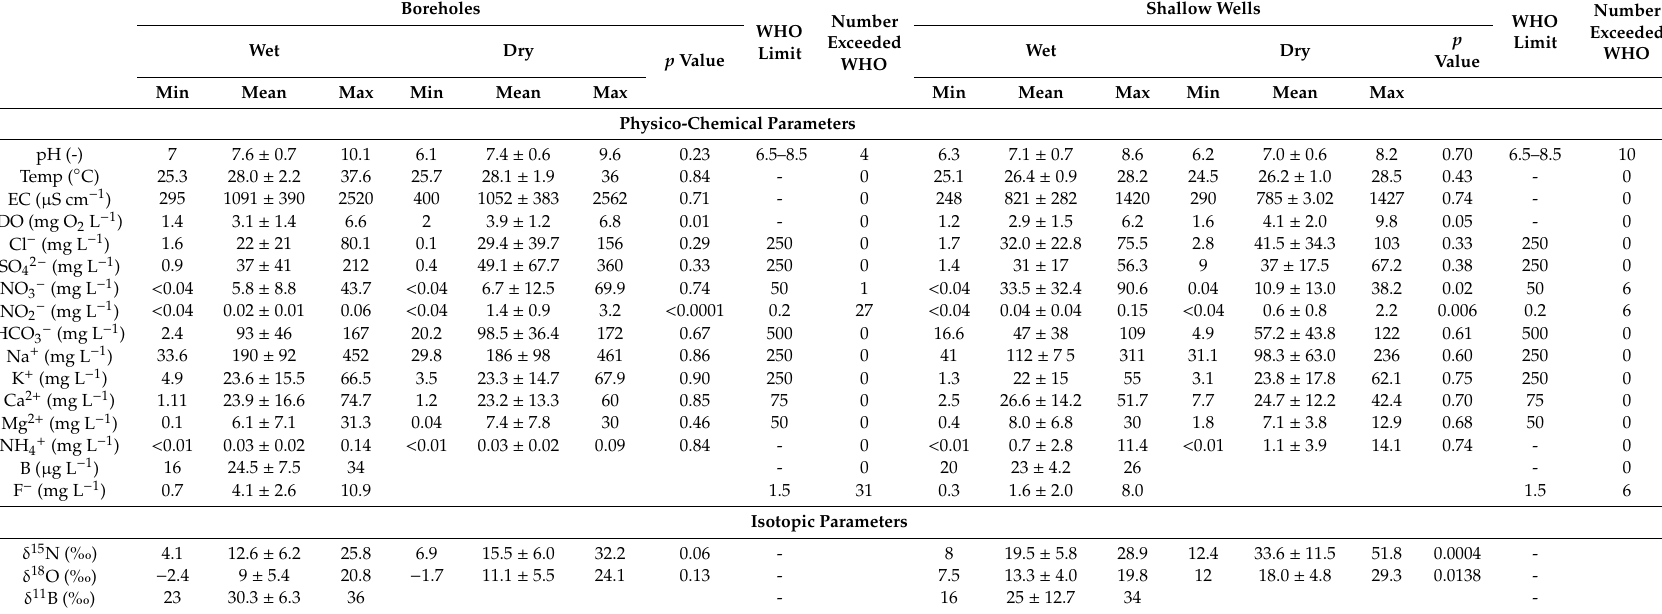
Table 1. Statistical summary of hydro-chemical and isotopic parameters for boreholes ( n = 44) and shallow wells ( n = 18) sampled during wet and dry seasons. WHO limit stands for World Health Organization standard limits for drinking water; DO stands for dissolved oxygen; p -value represents the ANOVA (at p < 0.05 levels) output for testing di ff erences of parameters between wet and dry